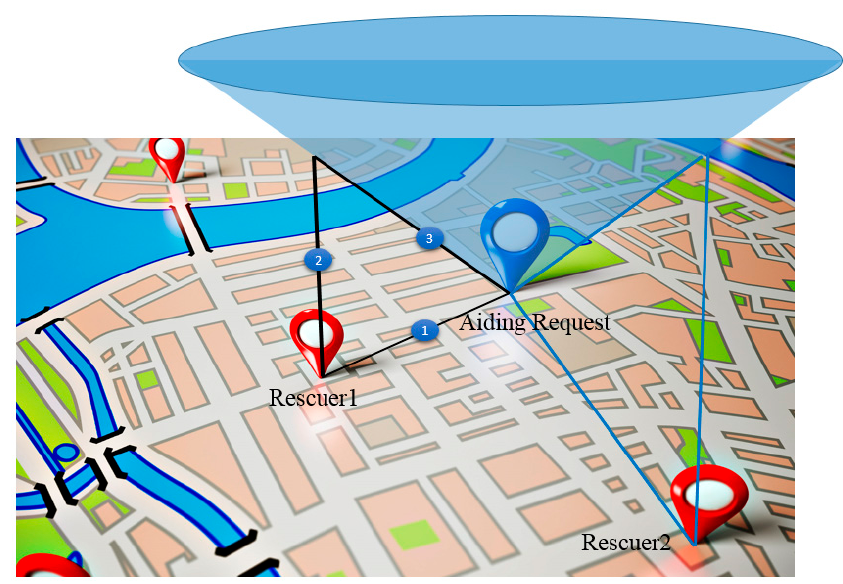
Figure 5. E ff ectiveness cone of given aiding request. Figure 5. Effectiveness cone of given aiding request.